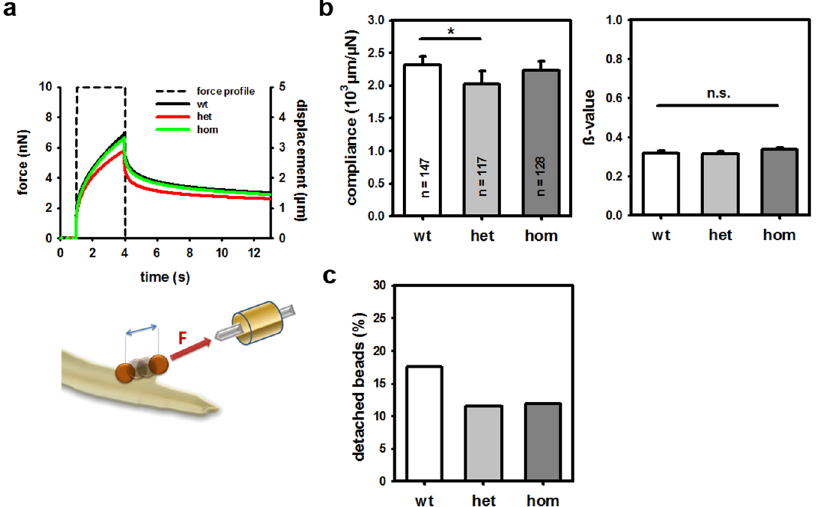
Figure 9. Lateral passive biomechanics properties from myoblasts derived from wt, het, and hom Des R349P mice. ( a ) Schematics of the magnetic tweezer experiments applying a constant magnetically-induced force of 10 nN for 3 s to myoblasts into which magnetic fibronectin-coated micro-beads had been coated to the membrane focal adhesion complexes. Shown are mean displacement curves during the ‘force on’ and ‘force off’ phase from which the stiffness and visco-elastic behavior were extracted. ( b ) Lateral compliance values (median values due to log-normal distribution) of the membrane and near-membrane cytoskeleton complex in 147 wt, 117 het, and 128 hom myoblasts as well as the visco-elastic parameter ß (mean values). ( c ) Percentage of detached beads during the ‘force-on’